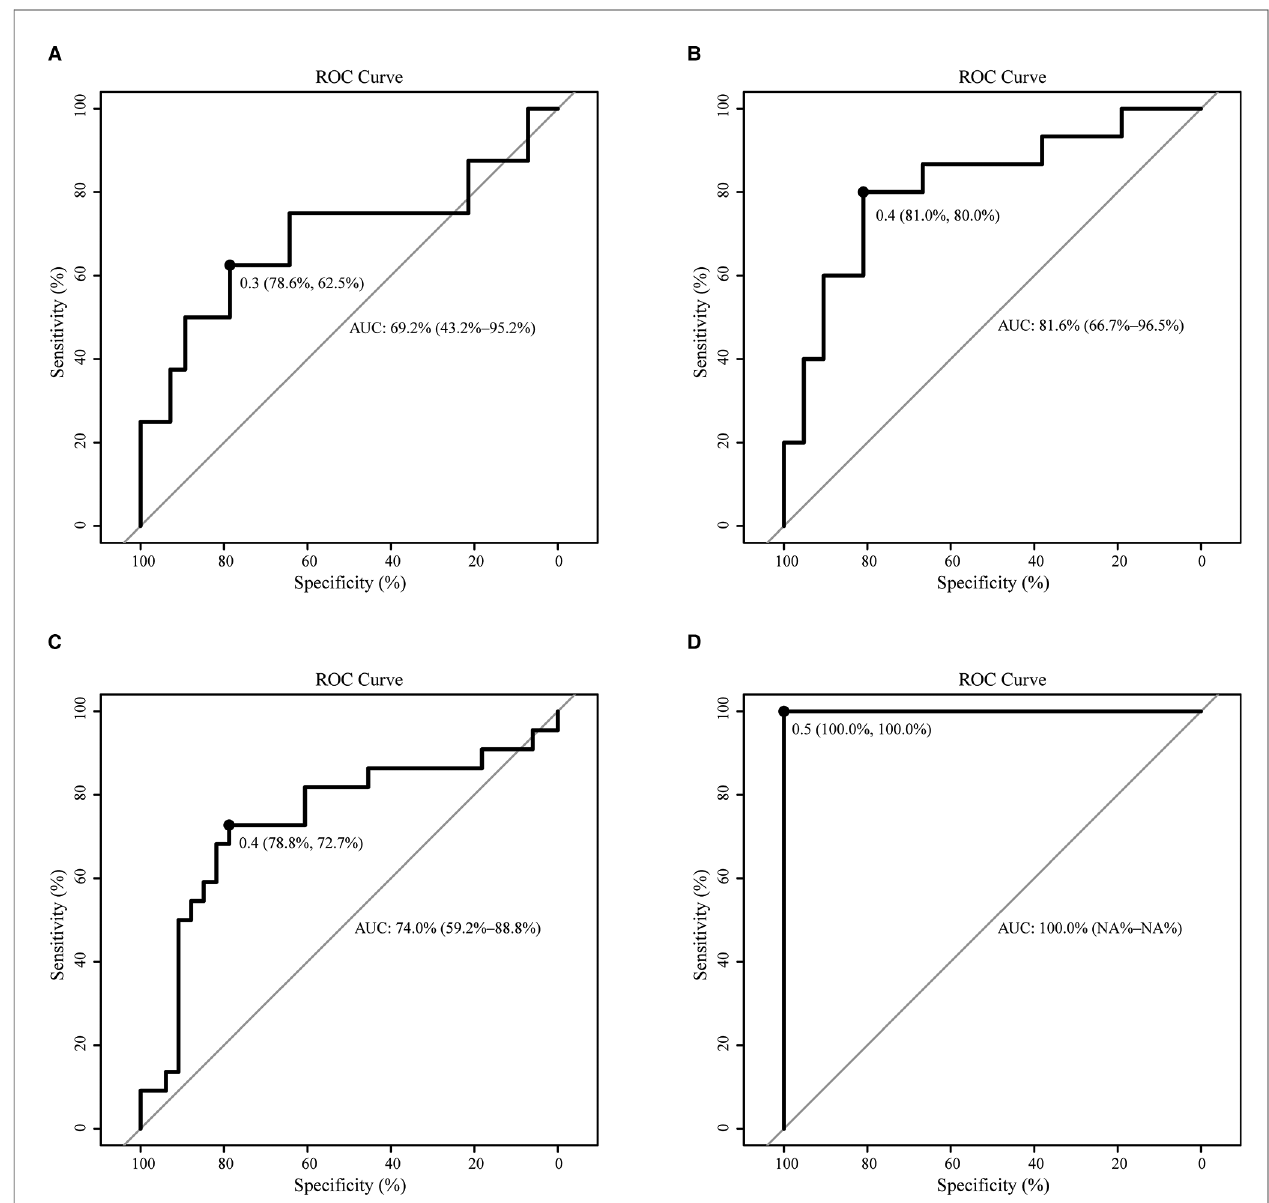
FIGURE 6 | Subgroup validation of the model. ( A ). ROC of the early cohort ( N =36); ( B ). ROC of the late cohort ( N =36); ( C ). ROC of the long-time cohort ( N =55); ( D ). ROC of the short-time cohort ( N